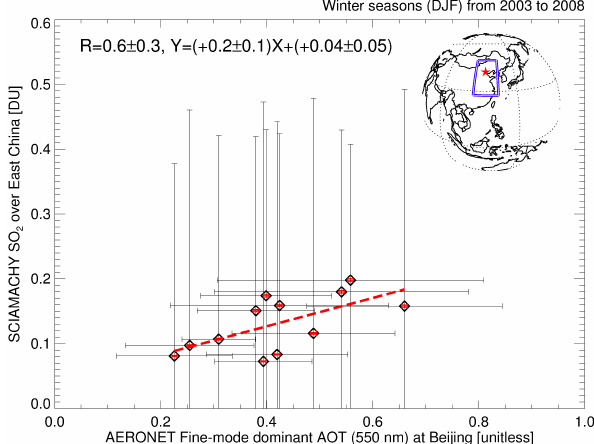
Figure 14. Plot of the correlation between AERONET fine-mode dominant AOT at Beijing and SCIAMACHY tropospheric SO 2 in winter seasons from 2003 to 2008. Black and red error bars show natural variability and standard retrieval error within a 95% con- fidence level, respectively. Some AERONET fine-mode dominant data are not available in some winter months due to insufficient number of observations per month (Yoon et al.,